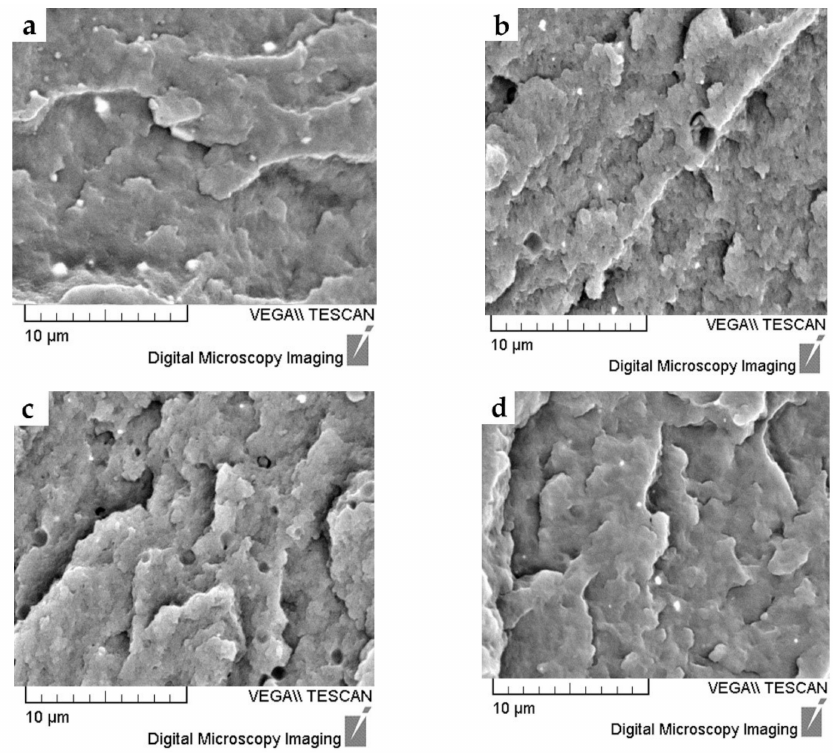
Figure 3. SEM micrographs of ( a ) specimens made according to experiment No. 1, ( b ) specimens made according to experiment No. 5, ( c ) specimens made according to experiment No. 8, and ( d ) specimens made according to experiment No. 9.